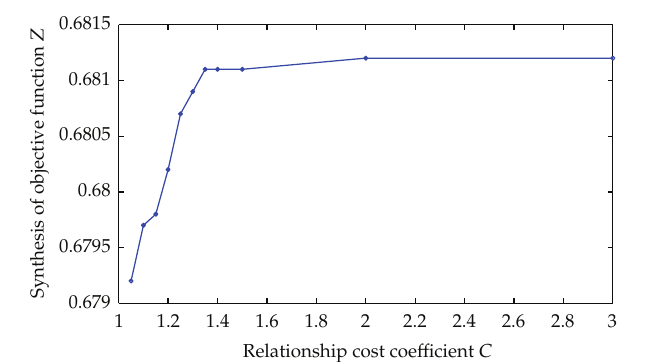
Figure 5: Curve of Z changed with C .